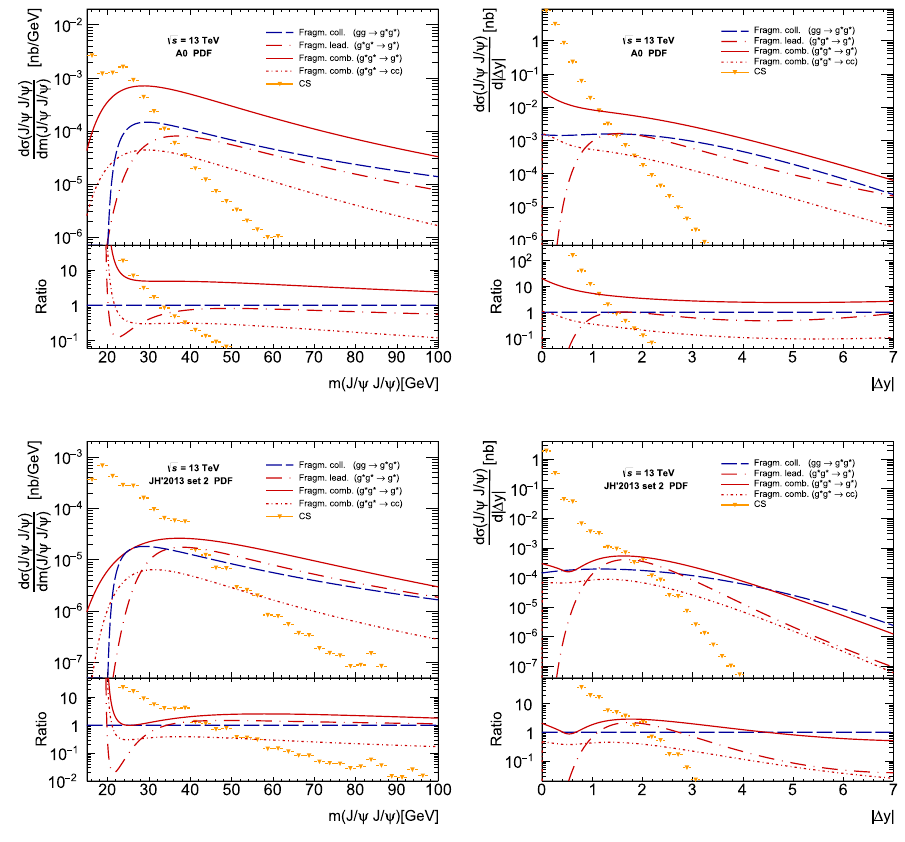
Fig. 5 Different contributions to the double J /ψ production calculated as functions of invariant mass m ( J /ψ, J /ψ) and rapidity separation | (cid:6) y ( J /ψ, J /ψ) | at √ s = 13 TeV. The kinematical cut p T ( J /ψ) > 10 GeV is applied for both J /ψ mesons. The A0 (upper panels) and JH’2013 set 2 (lower panels) gluon distributions in proton are